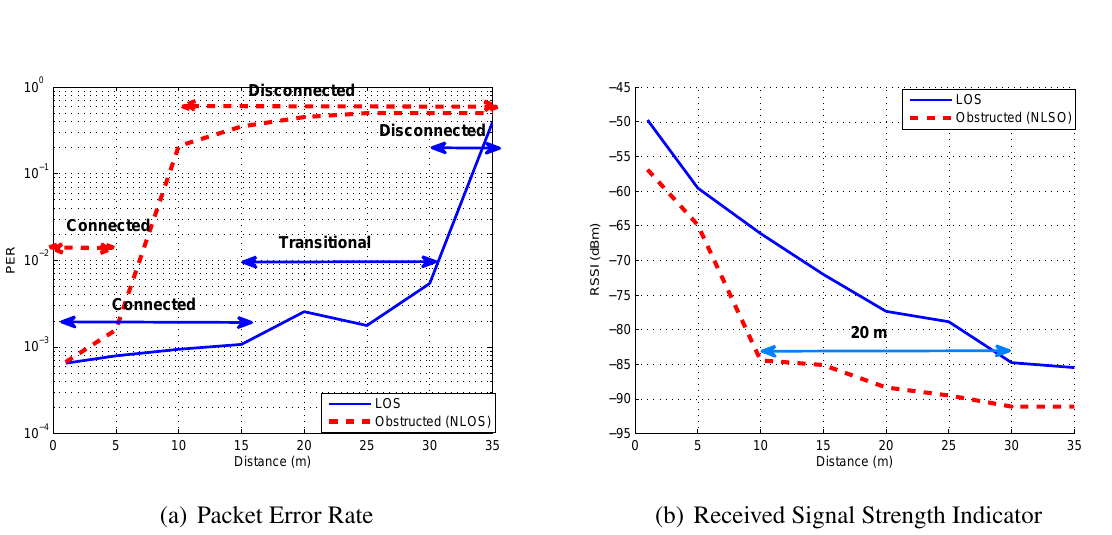
Figure 9. PER and RSSI against distance when nodes are obstructed (inside a drawer). Corridor Scenario.